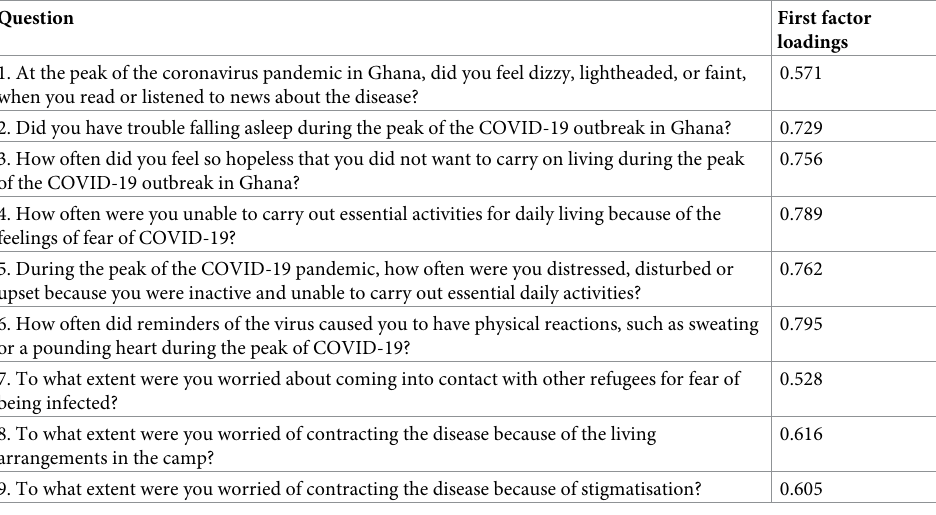
Table 1. COVID-19 Anxiety Scale questions for measuring psychological impact of